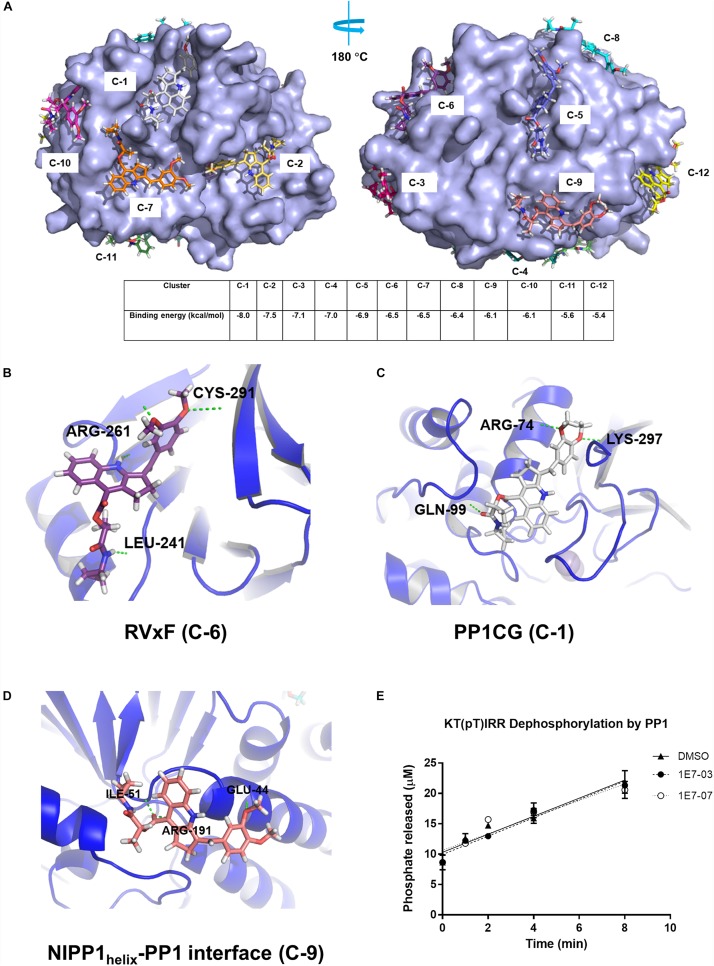
Identification of PP1 binding sites for 1E7-07 by molecular docking. Docking simulations using the Blind Docking Web Server as described in Section “Materials and Methods.” (A) A total of 283 binding positions were generated and sorted into 12 clusters according to the binding energy (from –5.4 to –8.0 kcal/mol). (B) 1E7-07 binds to the RVxF site of PP1 and forms hydrogen bonds with Leu-241, Arg-261 and Cys-291 (–6.5 kcal/mol, position C-6). (C) 1E7-07 binds to the PP1 C-terminal groove and forms hydrogen bonds with Arg-74, Gln-99, and Lys-297 (–8.0 kcal/mol, position C-1). (D) 1E7-07 binds to the NIPP1helix-PP1 interface with hydrogen bond formation with residues Glu-44, Ile-55, and Arg-191 (–6.1 kcal/mol, position C-9). The residues in close proximity to the ligand (cut-off distance of 8 Å) determined by PyMOL 1.5 software. (E) Effect of 1E7-07 and 1E7-03 on PP1α catalytic activity was measured using malachite green dephosphorylation assay (as described in section Materials and Methods) with PP1α and KT(pT)IRR peptide as substrate. The reactions were carried for the indicated time in the presence of 100 μM 1E7-07, 100 μM 1E7-03 or DMSO as vehicle control. Released phosphate concentration was determined by the absorbance of malachite green and a calibration curve.